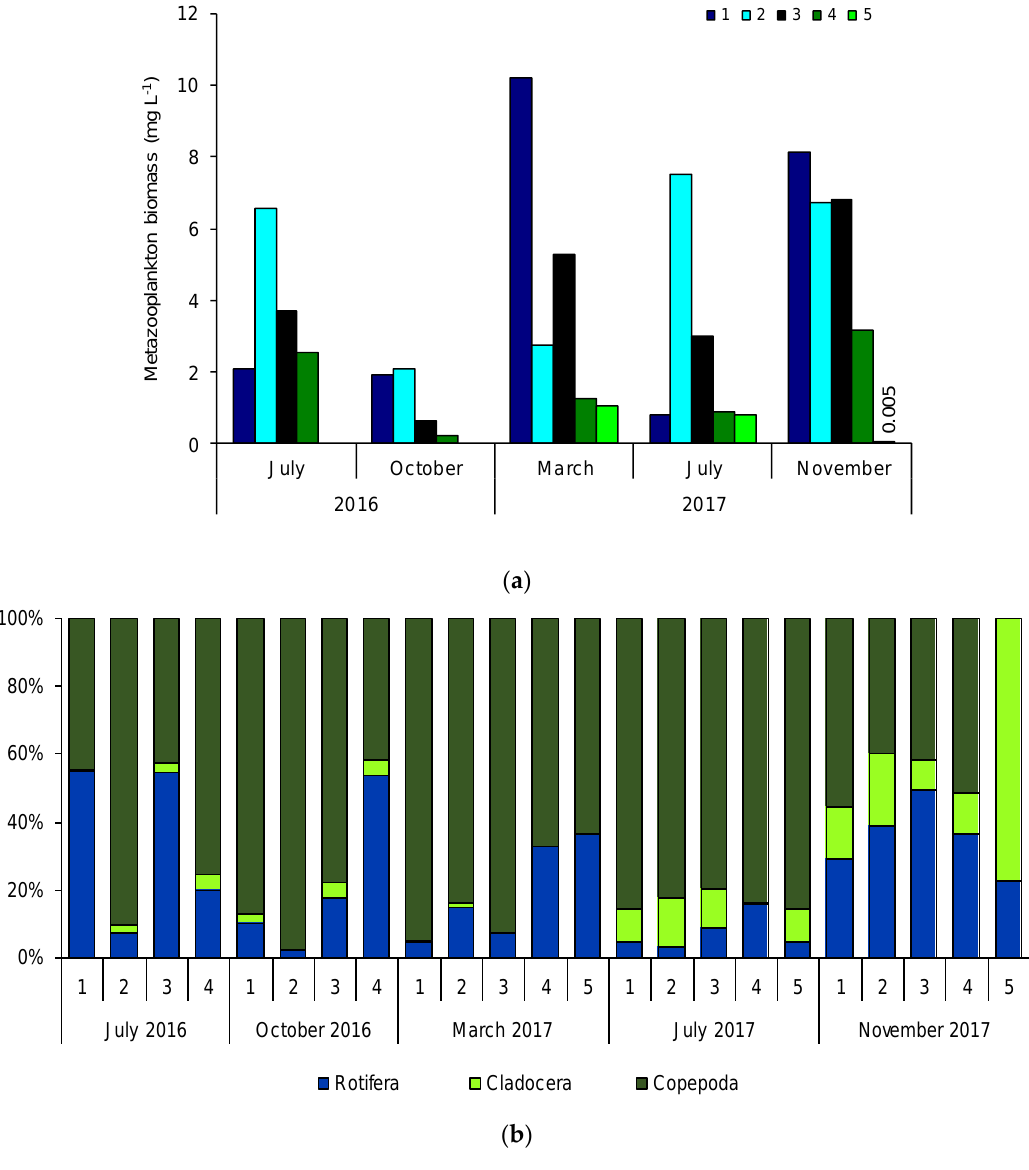
Figure 6. Temporal and spatial distribution of rotifer and crustacean biomass ( a ) and composition ( b ); sites 1 –4 in Lake Warnołty, site 5 in Lake Śniardwy.